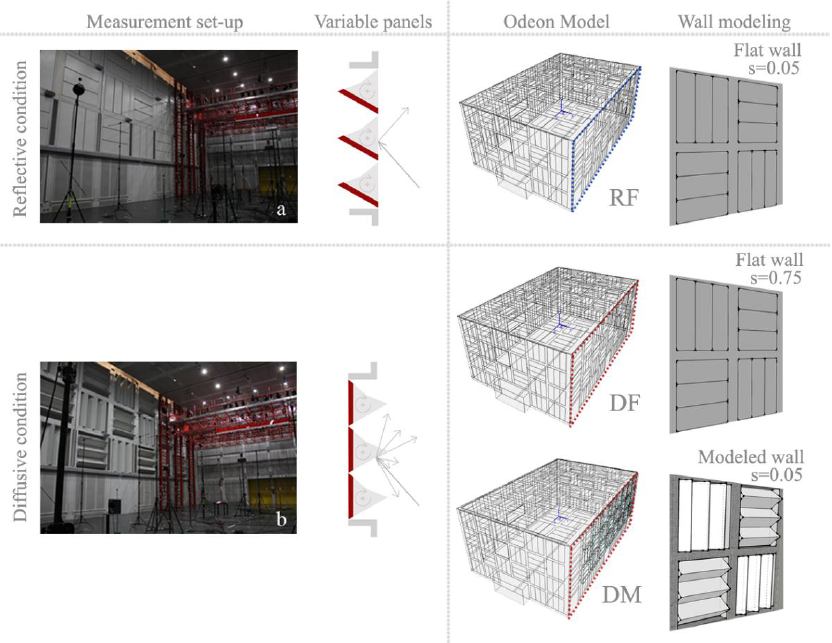
Figure 1. Photos of the two acoustic conditions in the hall: reflective ( a ) and diffusive ( b ). CAD model (RF) for the reflective condition, which is modeled with flat surfaces and s = 0.05. Two CAD models for the diffusive condition: DF (diffusive flat) the prisms have been modeled as a flat surface with s = 0.75, while in the DM (diffusive modeled) the triangular structure has been maintained and s = 0.05 is assigned to each small face.